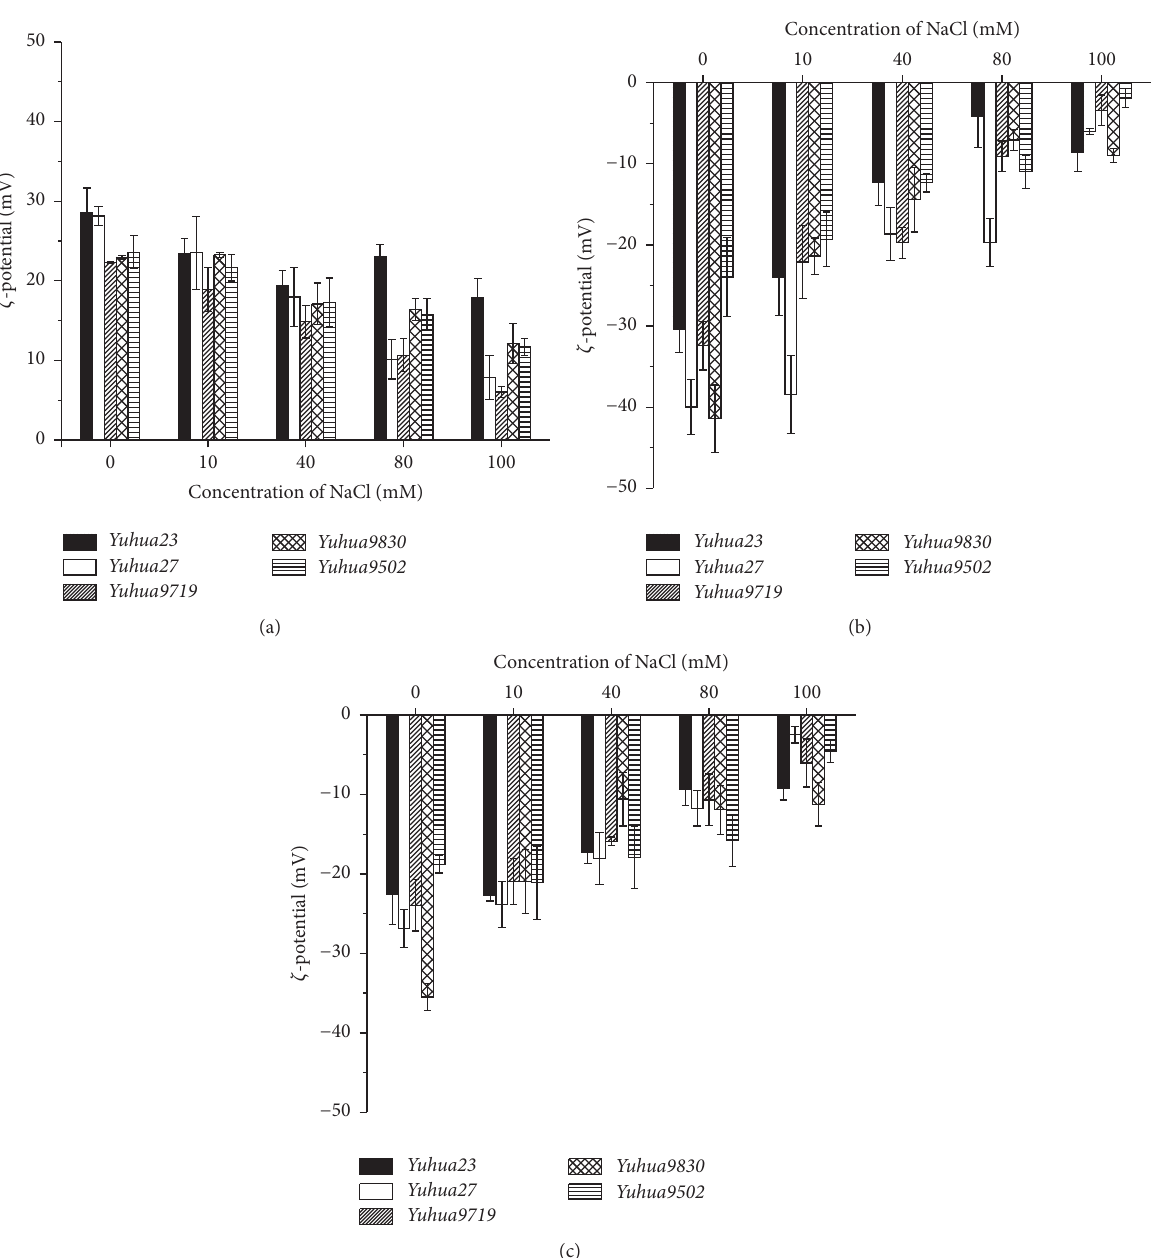
Figure 3: 𝜁 -potential of peanut oil bodies at different salt concentrations under various pH values ((a) pH3.0, (b) pH7.4, and (c) pH9.0), where error bar represents standard